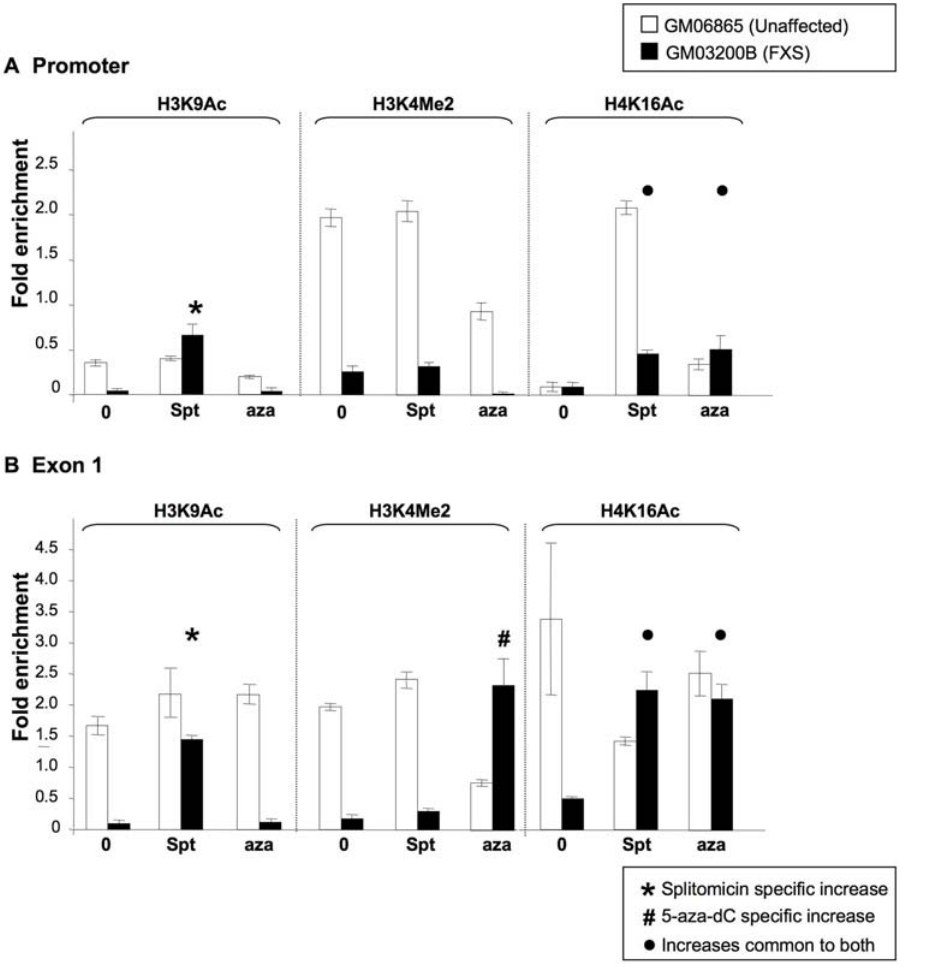
Figure 5. Splitomicin and 5-aza-dC-induced chromatin changes at the 5 9 end of the FMR1 gene in affected and unaffected individuals. Lymphoblastoid cells from an unaffected (GM06865) and affected individual (GM03200B) were treated with 700 m M splitomicin and 10 m M 5-aza-dC as before. ChIP was performed using antibodies to H3K9Ac, H4K16Ac and H4Kme2. Real time PCR was carried out on the immunoprecipitated material and the results expressed as the percentage of input DNA and normalized to GAPDH. Panels A depicts the chromatin modifications occurring in untreated and treated cells in the promoter region. Panel B depicts the chromatin modifications occurring in untreated and treated cells in exon 1.